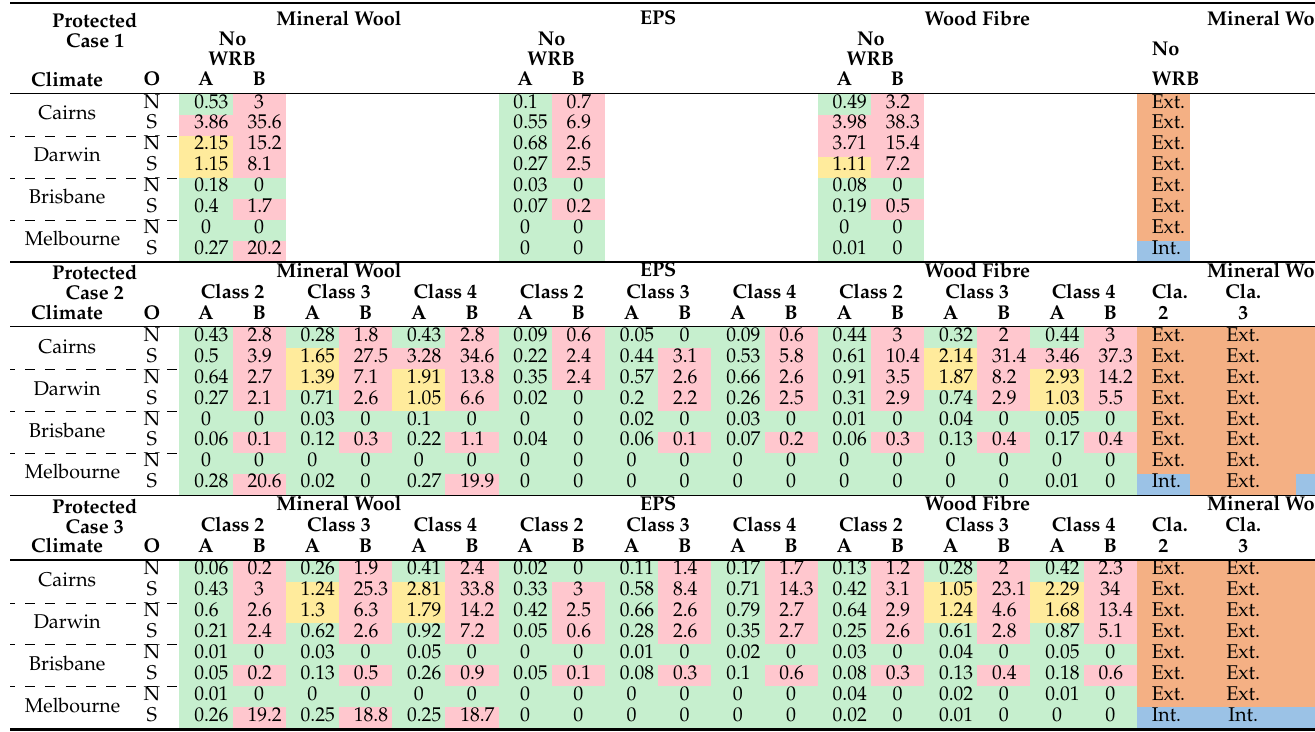
Table A2. Protected CLT results for split insulation. O (orientation). Performance criteria: A (mould growth index), B (corrosion rate). Classification of WRB: Class 2, 3, and 4 (vapour permeance). Green (pass), red (fail), or yellow (further investigation). Critical surface that fails the performance criteria indicated in right table: Ext. (external surface), Int. (internal surface), Both (both